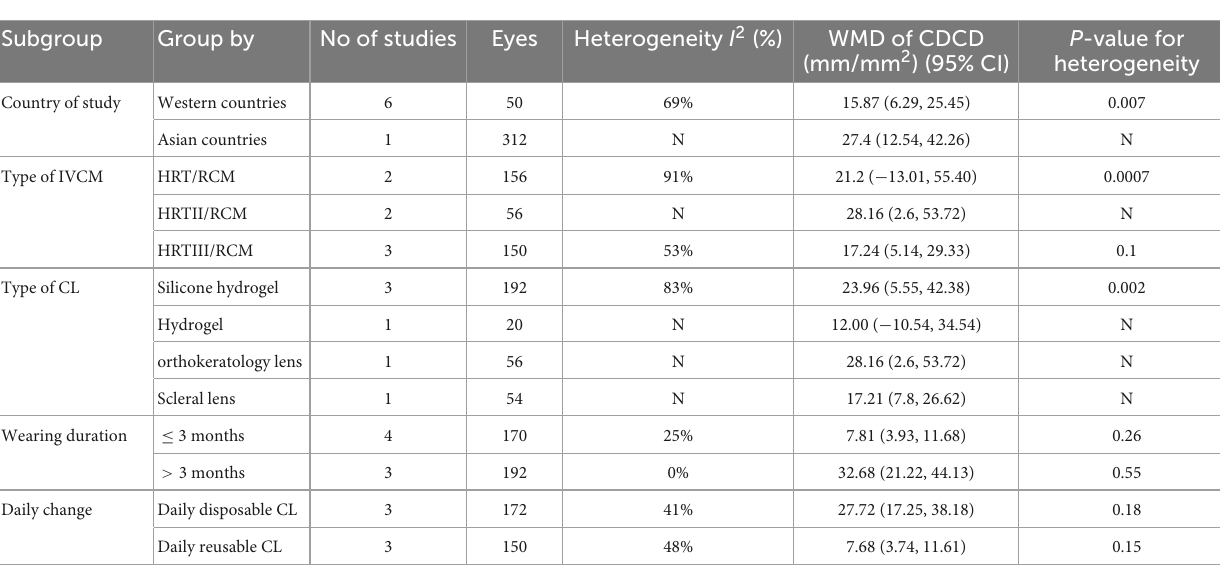
TABLE 3 Subgroup meta-analysis of CDCD.